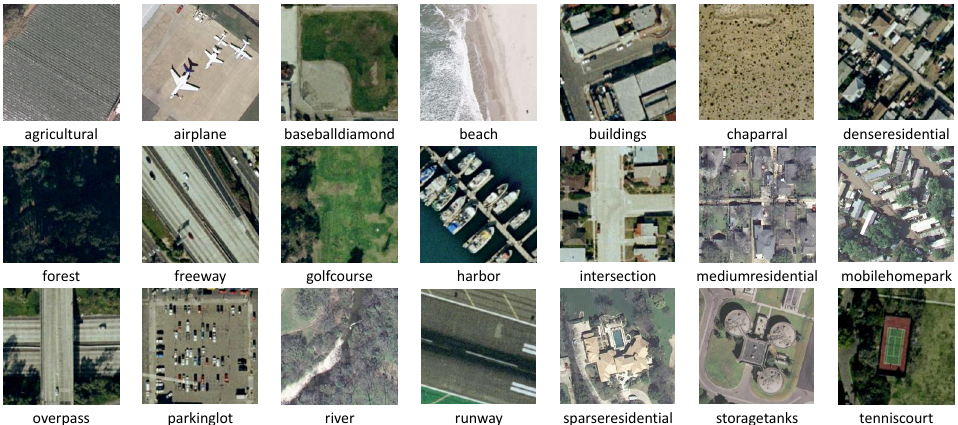
Figure 8. UC-Merced dataset: some example images are displayed. It contains 21 scene categories, with 100 samples per class. The images are of a size of 256 × 256 pixels with a pixel resolution of one